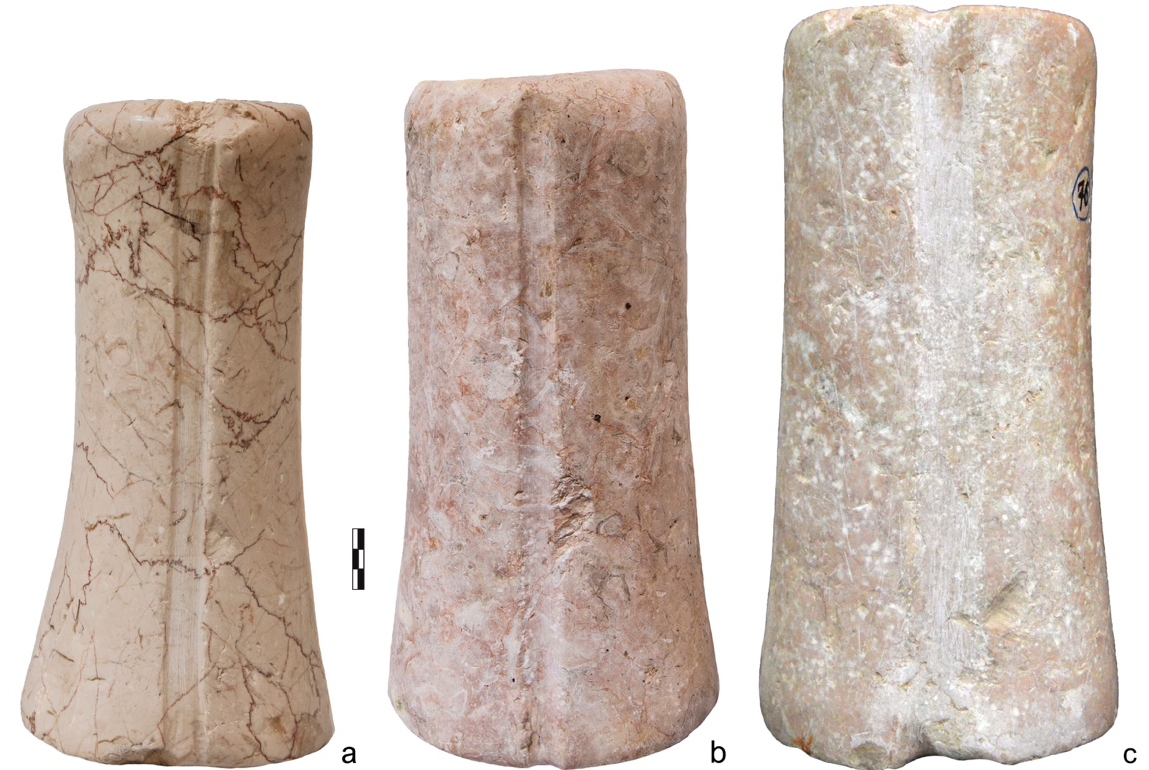
Figure 10. Types of grooves on the side of miniature columns from Gonur Depe (a, b. from the depositories of the National Museum of Turkmenistan, Ashgabat; c. from the depositories of the Local history museum of Mary province, Turkmenistan): a. narrow groove with a rectangular profile; b. narrow groove with an arched profile, c. wide groove with an arched profile. Scale bar is 3 cm long, separated into three 1 cm